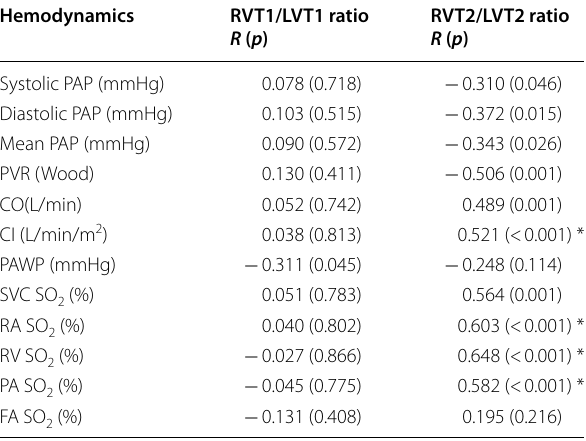
Table 3 Correlation of ventricular blood pool T1/T2 ratio with hemodynamics in PH